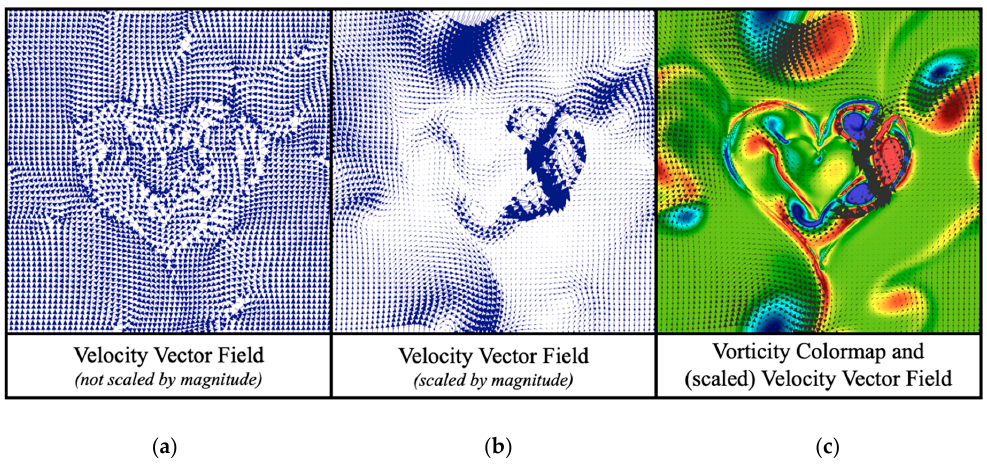
Figure 31. ( a , b ) Unscaled and scaled velocity vector field, respectively, that was used to define the initial fluid vorticity ( c ).